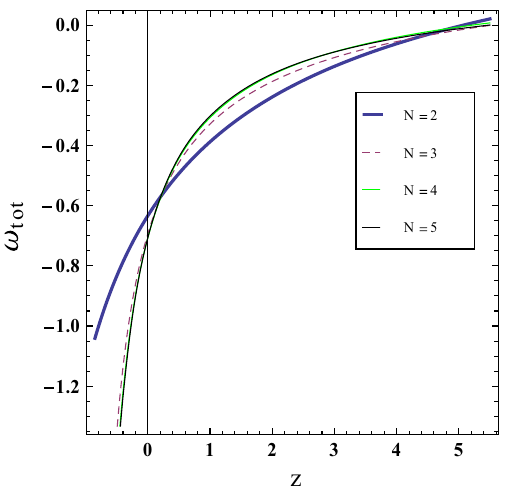
Fig. 4 The reconstructed total EoS parameter ω tot ( z ) for the best-fit model by considering different values of N , as indicated in the panel (see also Table 1)